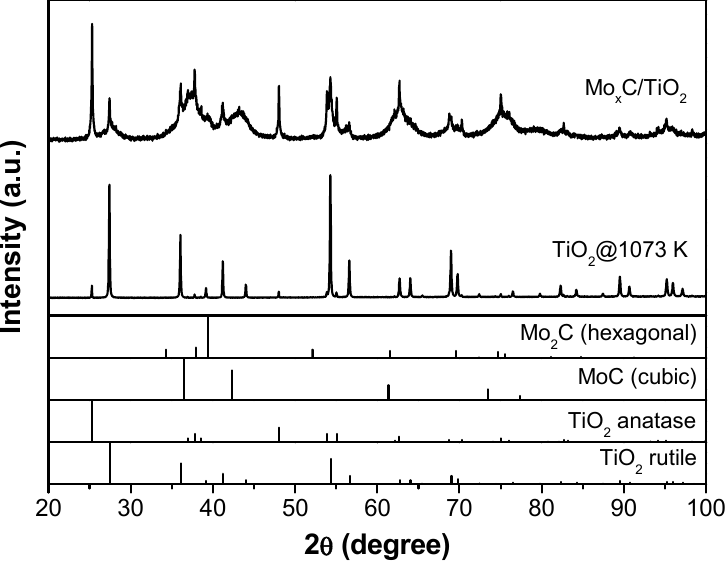
Figure 3. XRD patterns of Mo x C/TiO 2 catalyst and the TiO 2 support after thermal treatment at 1073 K.